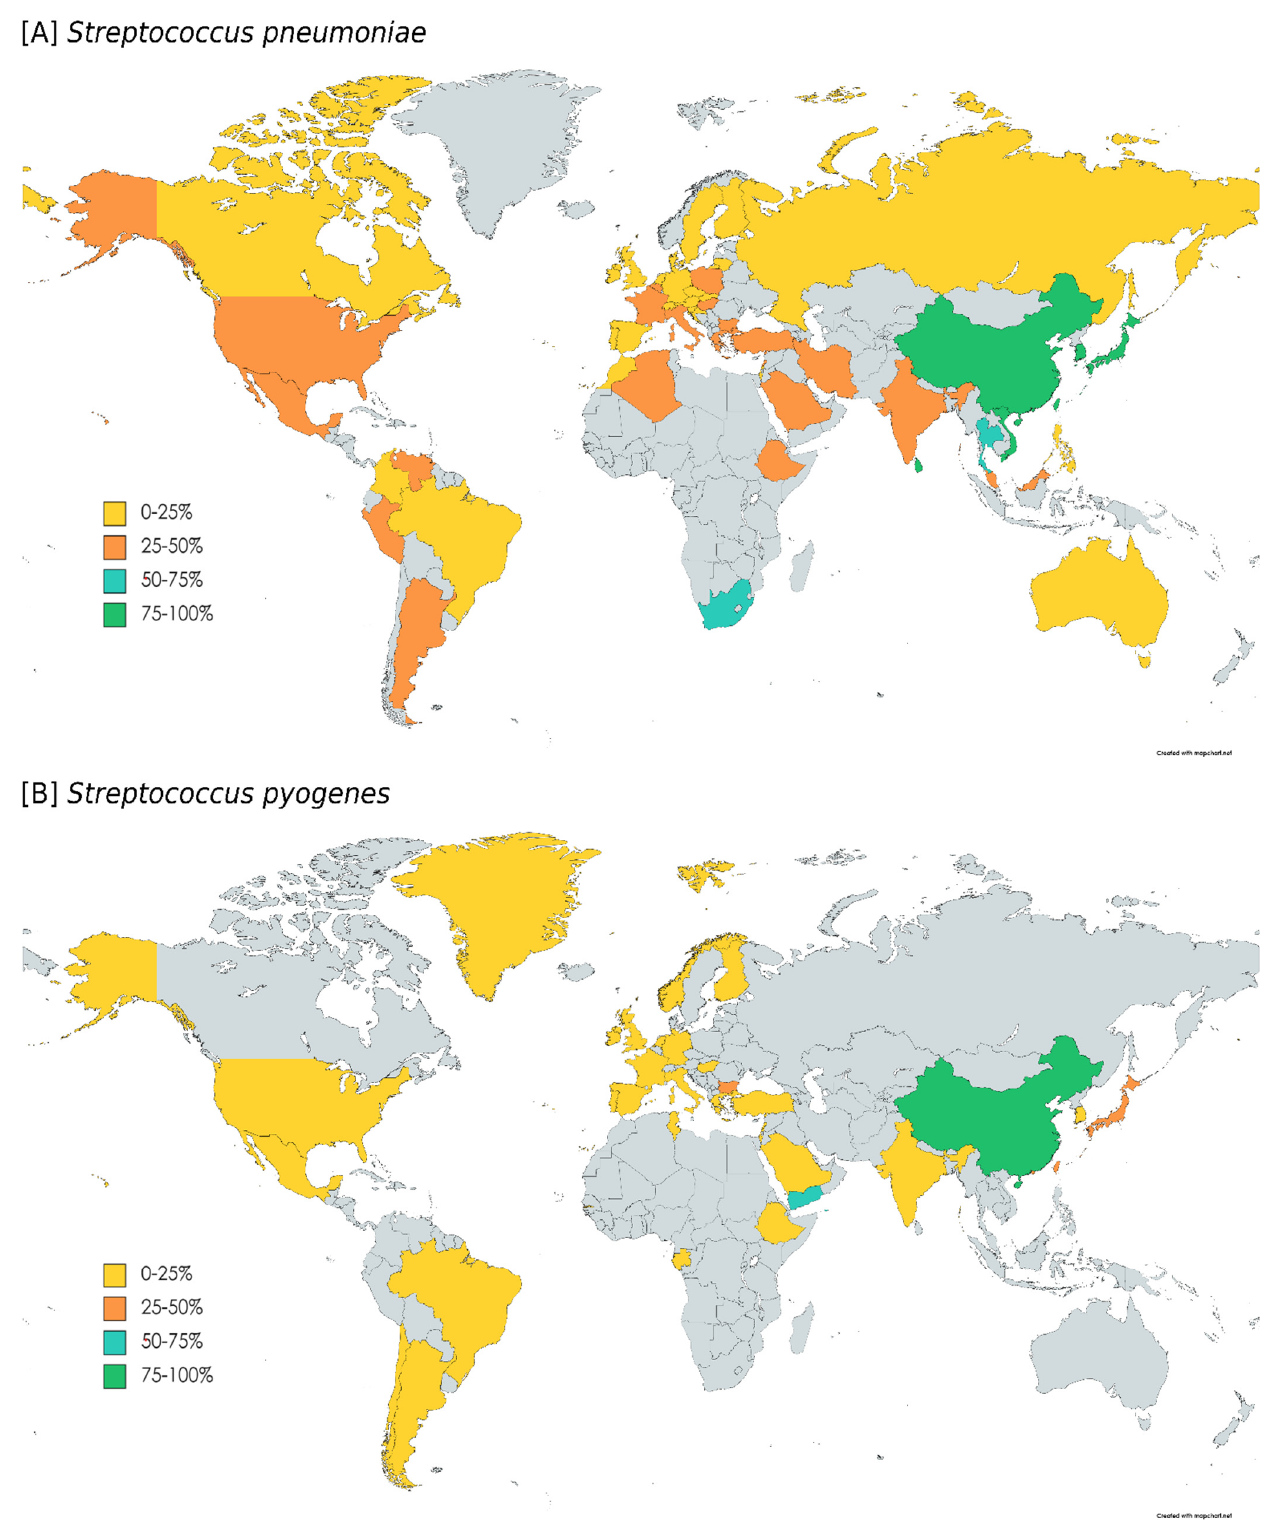
Figure 1. Macrolide resistance rates in the world: Streptococcus pneumoniae ( A ) and Streptococcus pyogenes ( B ). Macrolide resistance rates reported in Supplementary Table S1 are depicted as yellow (0–25%), orange (25–50%), blue (50–75%) and green (75–100%) zones, and grey zones mean countries with no data.